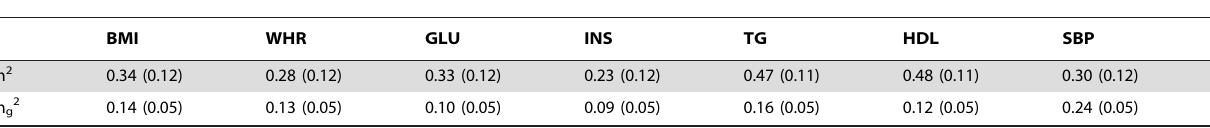
Table 1. h 2 and h g2 estimates (ARIC